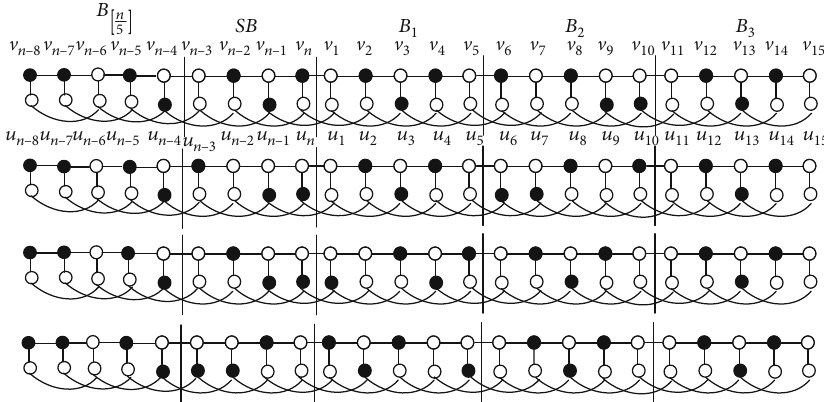
, B , SB with 10 guards. 1 2